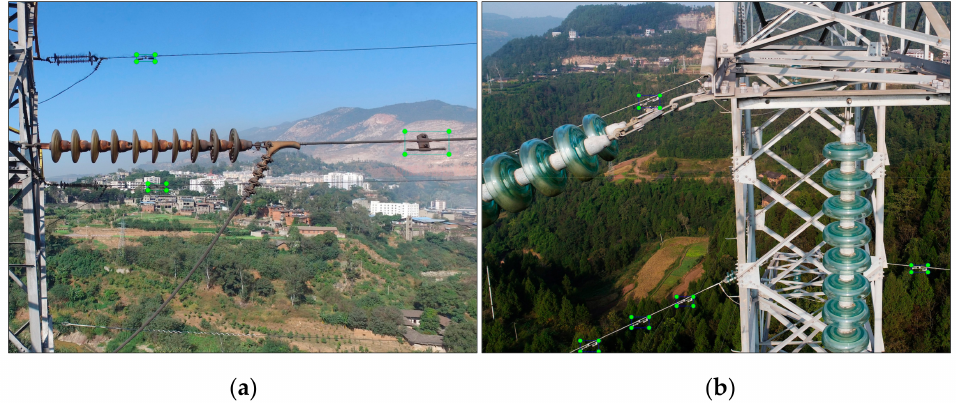
Figure 7. Examples of annotated UAV remote sensing images: ( a ) containing “rusty” and “defective” dampers; ( b ) containing “normal” dampers.